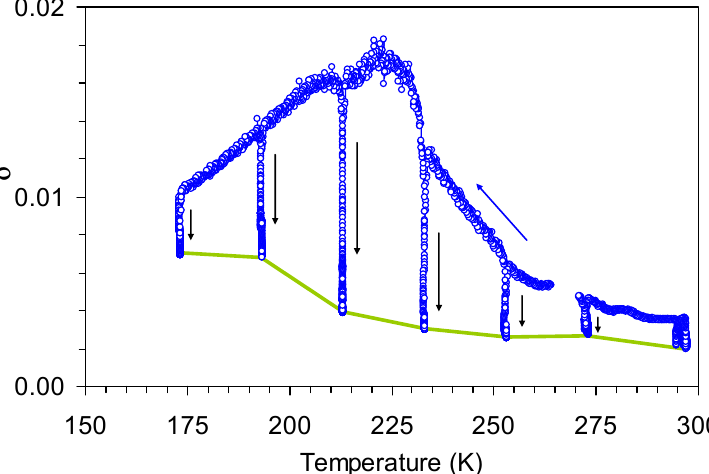
Figure 6. Temperature dependence of the internal friction for a Structure 1 sample with two a/c twin boundaries in a cooling scan between 290 and 173 K interrupted for 2400 s at 273, 253, 233, 213, 193 and 173 K, as shown in Figure 4. Cooling rate 1 K/min, strain amplitude 2 × 10 − 7 . Green line demonstrates the temperature spectrum under isothermal conditions. Vertical arrows mark isothermal decrease in the internal friction with time during interruptions of cooling.